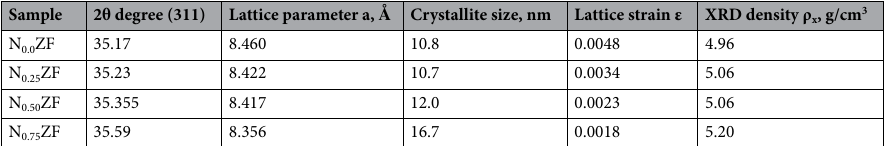
Table 5. Results of the XRD test for the NZF samples.